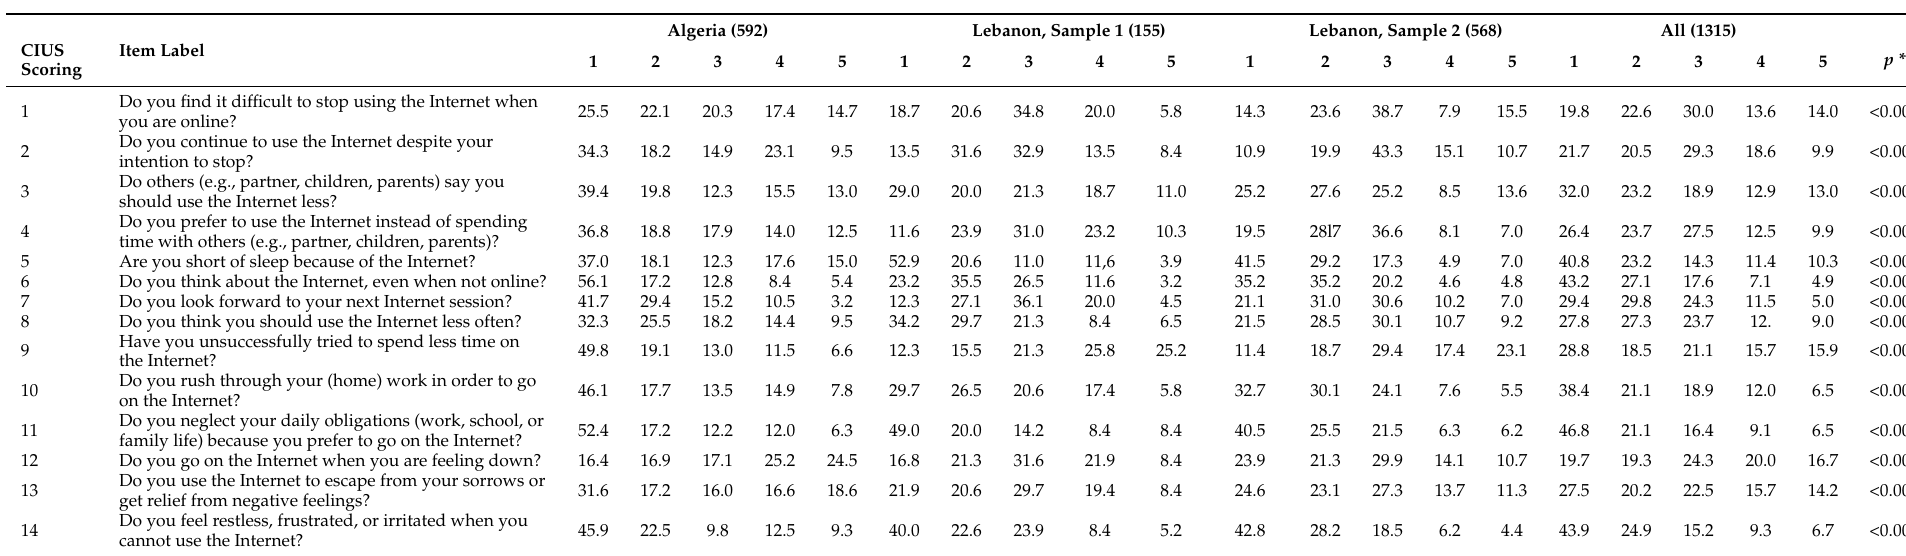
Table 2. Item distribution of the CIUS by